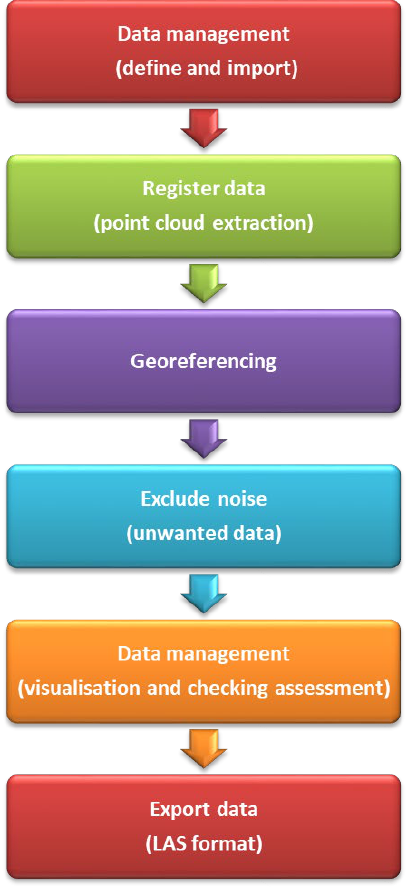
Figure 11. Point cloud processing